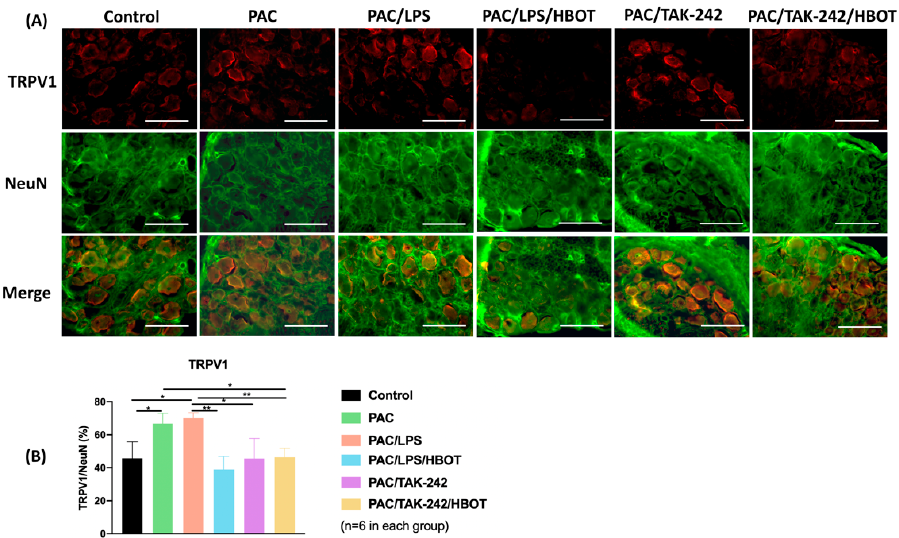
Figure 6. TRPV1 expression in rat DRG. ( A ) IF images indicating TRPV1 antibody staining from the control, PAC, PAC/LPS, PAC/LPS/HBOT, PAC/TAK-242 and PAC/TAK-242/HBOT groups. IF staining of TRPV1 (indicated by red) and DRG neurons (NeuN, indicated by green) were performed. Scale bar indicates 100 µ m. ( B ) Representative bar graphs illustrating the percentage of TRPV1. Error bars, mean ± SEM ( n = 6 per group). * p < 0.05, ** p < 0.01 vs. control group. IF: immunofluorescence. DRG: dorsal root ganglion.